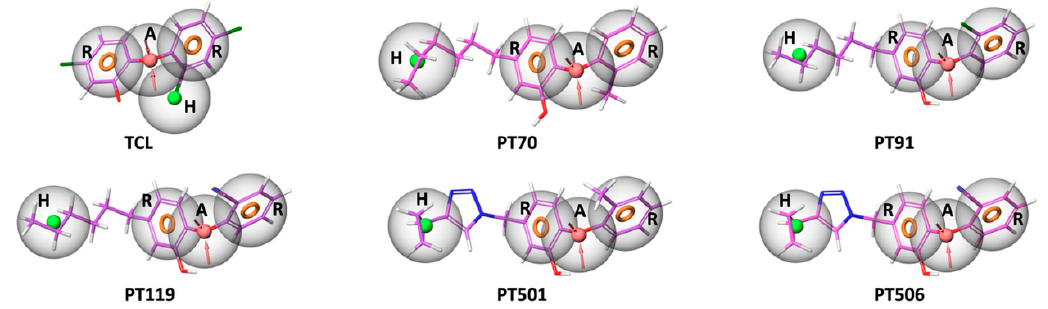
Figure 4. Alignment between the multiple ligand-based AHRR pharmacophore model and each inhibitor. The ligands are shown as purple sticks. Orange ring: aromatic ring (R), pink ball: hydrogen bond acceptor (A), green ball: hydrophobic group (H).